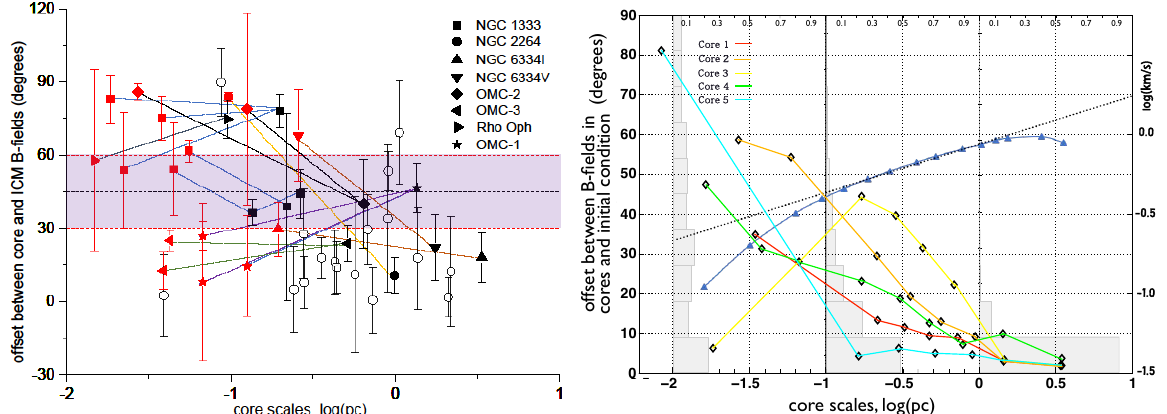
Figure 3. ( Left ): Core/ICM B-field directional offsets against the spatial scales of cores [12]. The black symbols are from the data in Li09 and the red symbols are interferometer data [27,28]. Data from Li09 with no interferometer counterparts are shown as hollow circles. The error bars indicate the interquartile ranges (IQRs), not error of the mean, of the B-field orientation distributions. Above ~0.1 pc, most of the offsets are smaller than 45 degrees. The upper envelope grows with decreasing scale, and, below 0.1 pc, there seems to be no polarizational direction preference at all. ( Right ): The results of sub-Alfv é nic cloud MHD simulations [12]. The diamonds show the 3D core field directions (measured from the initial uniform field direction; left axis) against the core sizes (bottom axis). Each of these 3D offsets is projected along 135 directions, evenly distributed over a 4 π sr solid angle. The scales are binned into “above 1 pc”, “below 0.1 pc”, and “in between”. The histograms present the fraction distribution of the projected 2D offsets in each bin (the upper axis is the fraction). Note that the 2D histograms are “folded” at 90 degrees (but the 3D offsets are not!), in order to emulate the disability of polarimetry observations in distinguishing supplementary offset angles. Additionally, the turbulent 3D velocity spectrum is plotted (the dark blue line; the velocity is shown in the right axis), which peaks at 2.4 pc (the turbulence driving scale) and is numerically dissipated below 0.1 pc. The dotted line (y = 0.90 x 0.31 ) is fit to the velocity spectrum between 0.1 and 1.25